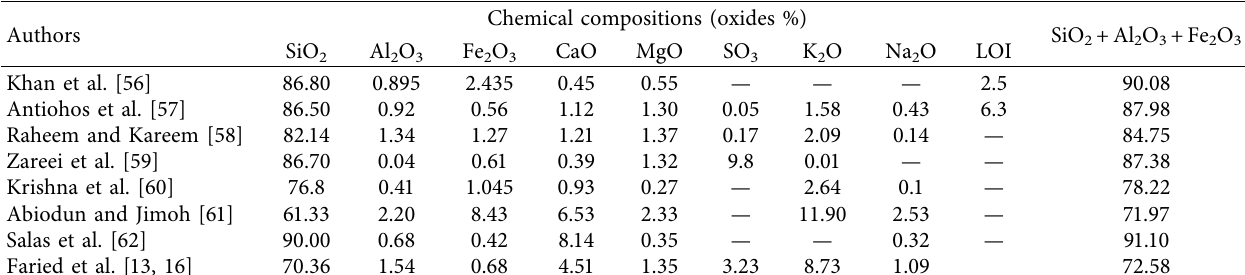
Table 5: Chemical compositions of rice husk ashes (RHA).